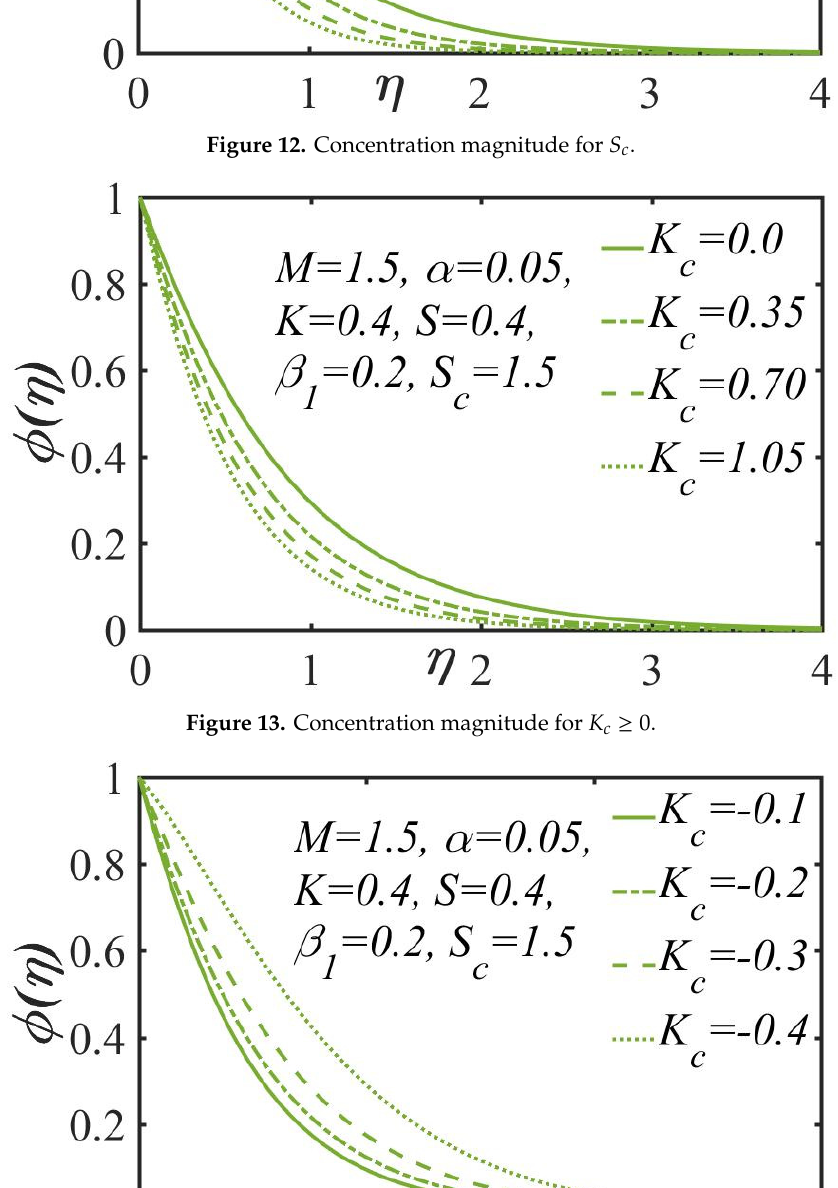
Figure 15. Skin friction coefficient with the fluctuation of (cid:2010) (cid:2869) .